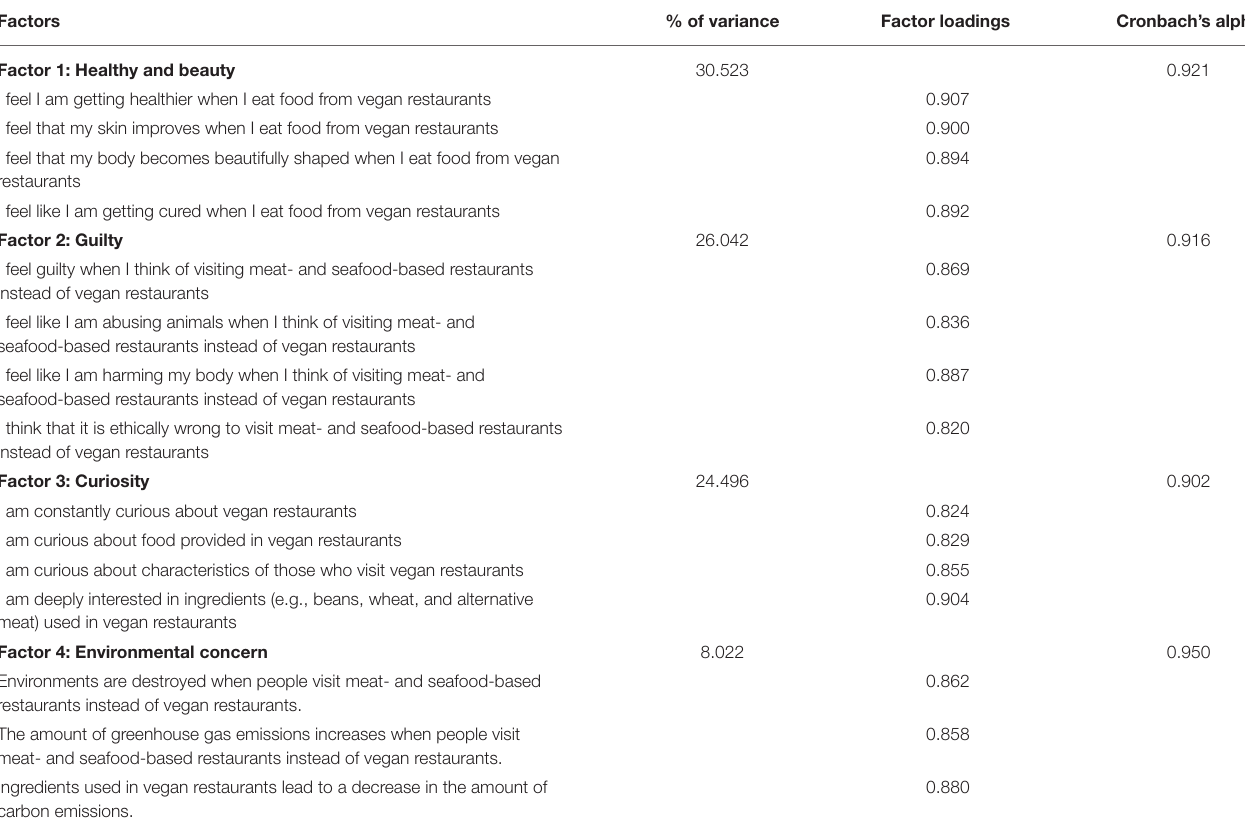
TABLE 1 | Summary of exploratory factor analysis